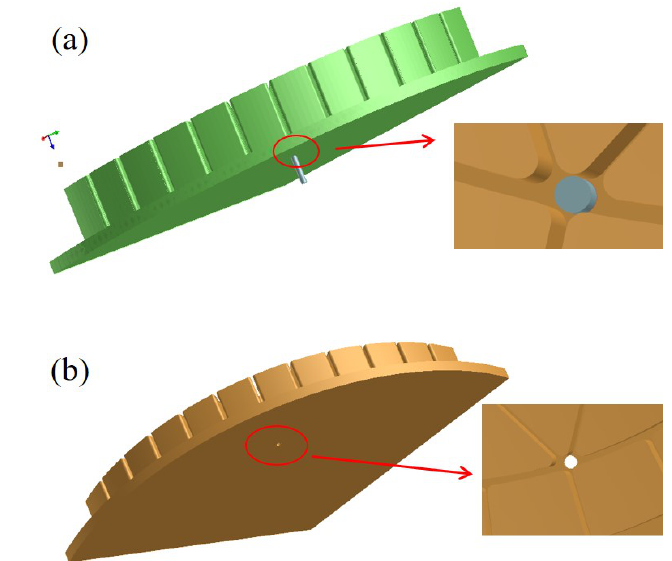
Figure 10. Schematic diagram of exhaust hole location. ( a ) without vent hole, ( b ) with a vent hole.